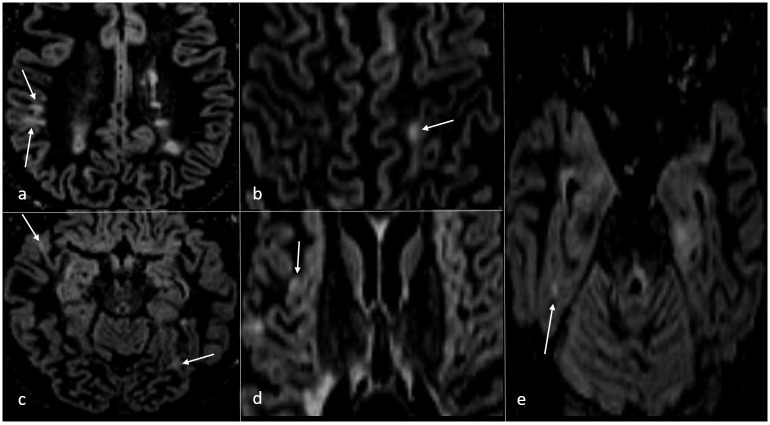
Overview of different CL types in distinct brain anatomical brain regions.Fig 2 displays different cortical lesion types in various anatomical brain regions marked by white arrows. Lesions appeared with varying volumes and signal intensities differed between distinct CLs.